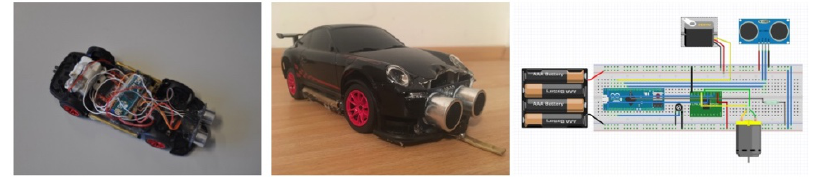
Fig. 9. Prototype of the model car and circuit diagram